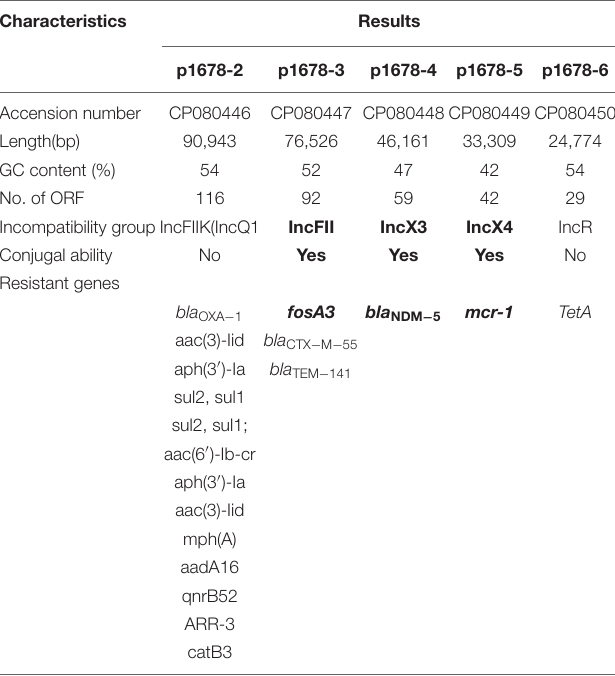
TABLE 2 | General features, antimicrobial resistance genes of plasmids in K. pneumoniae 1678.